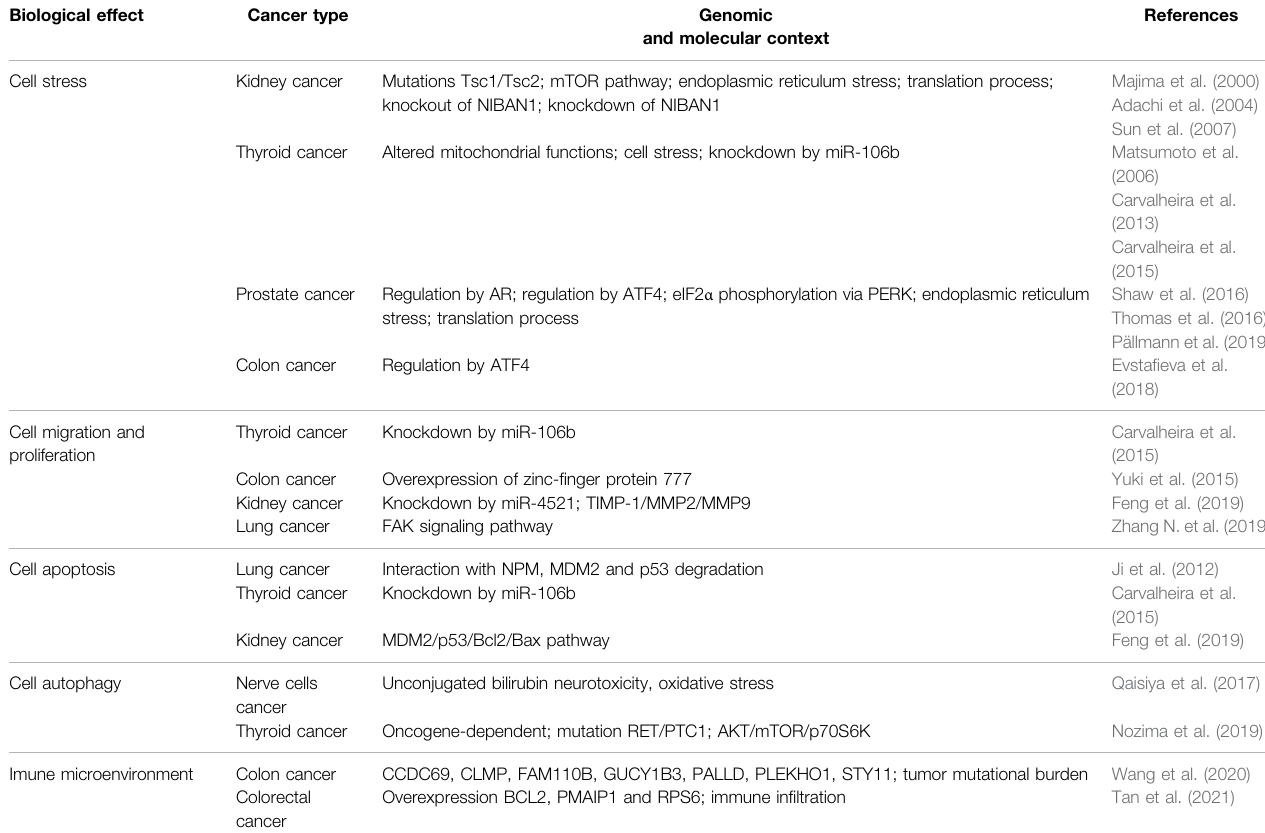
TABLE 1 | The biological effects of NIBAN1 upregulation in human